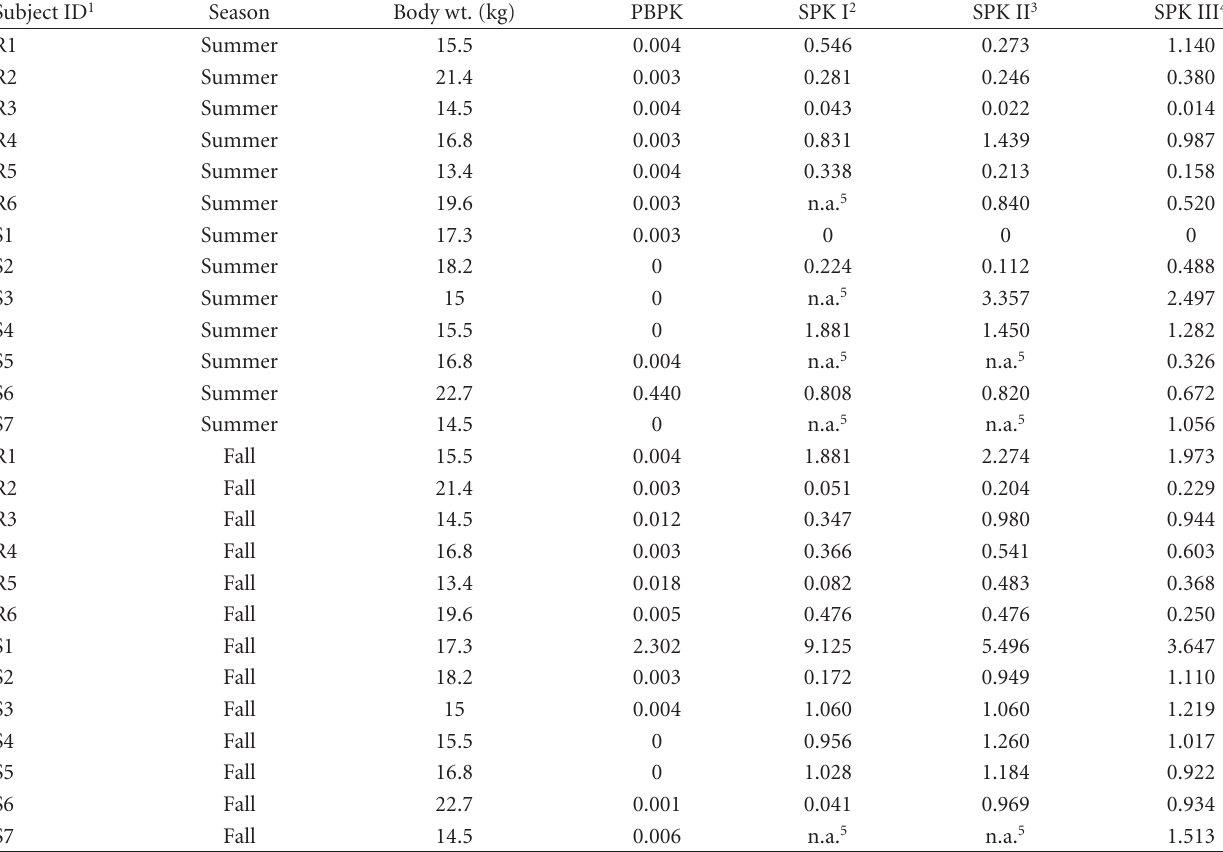
Table 2: The dose estimates ( µ g/kg/day) for chlorpyrifos using PBPK, SPK I, SPK II and SPK III model